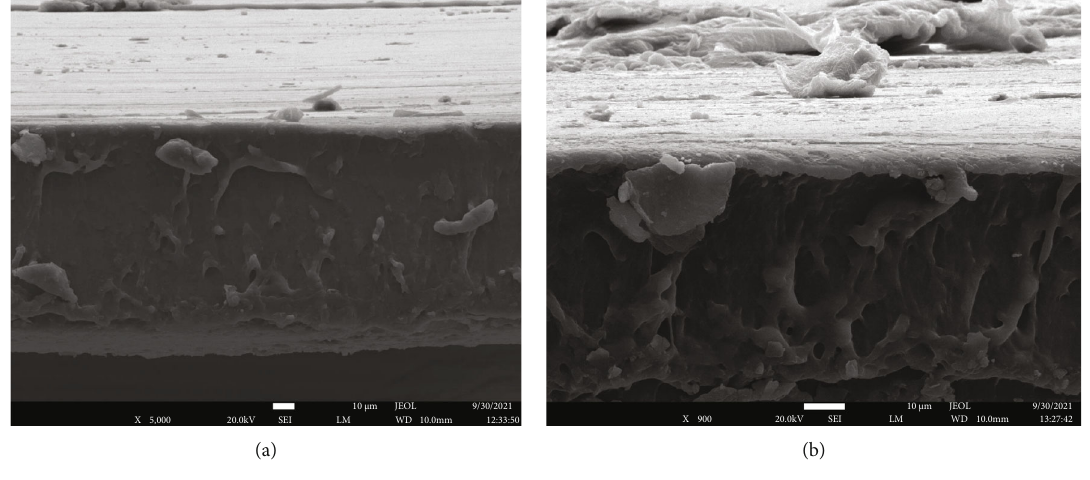
Figure 8: Cryofracture SEM images of nanocomposite fi Table 1: Antibacterial activity of the AgNP and fi lm-forming solution.